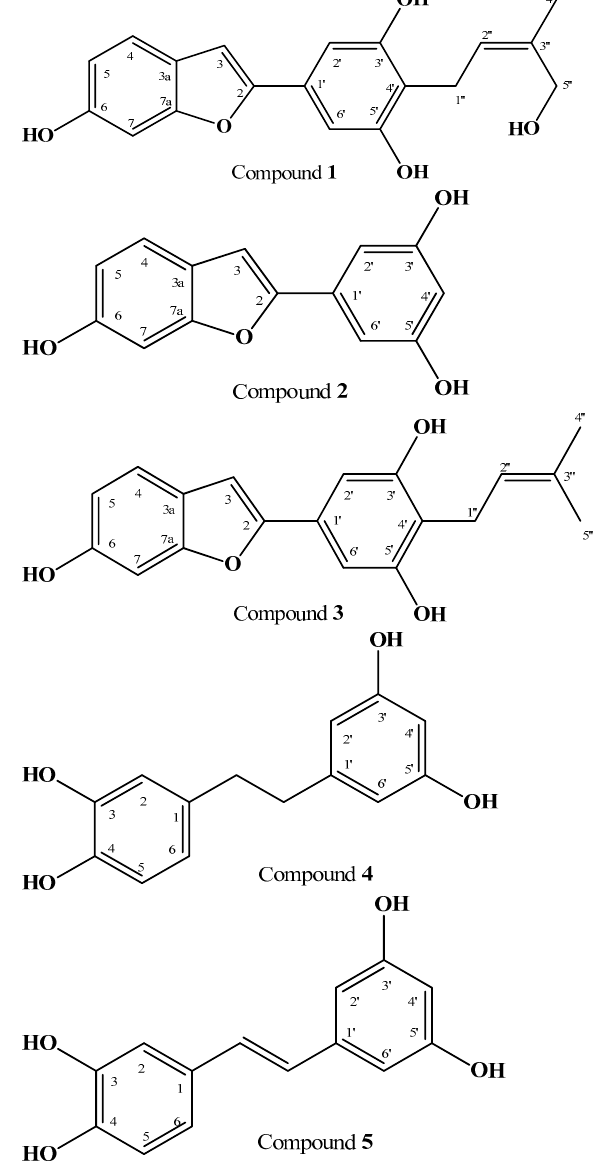
Figure 1. Isolated compounds from S. taxoides wood. ω -Hydroxymoracin C